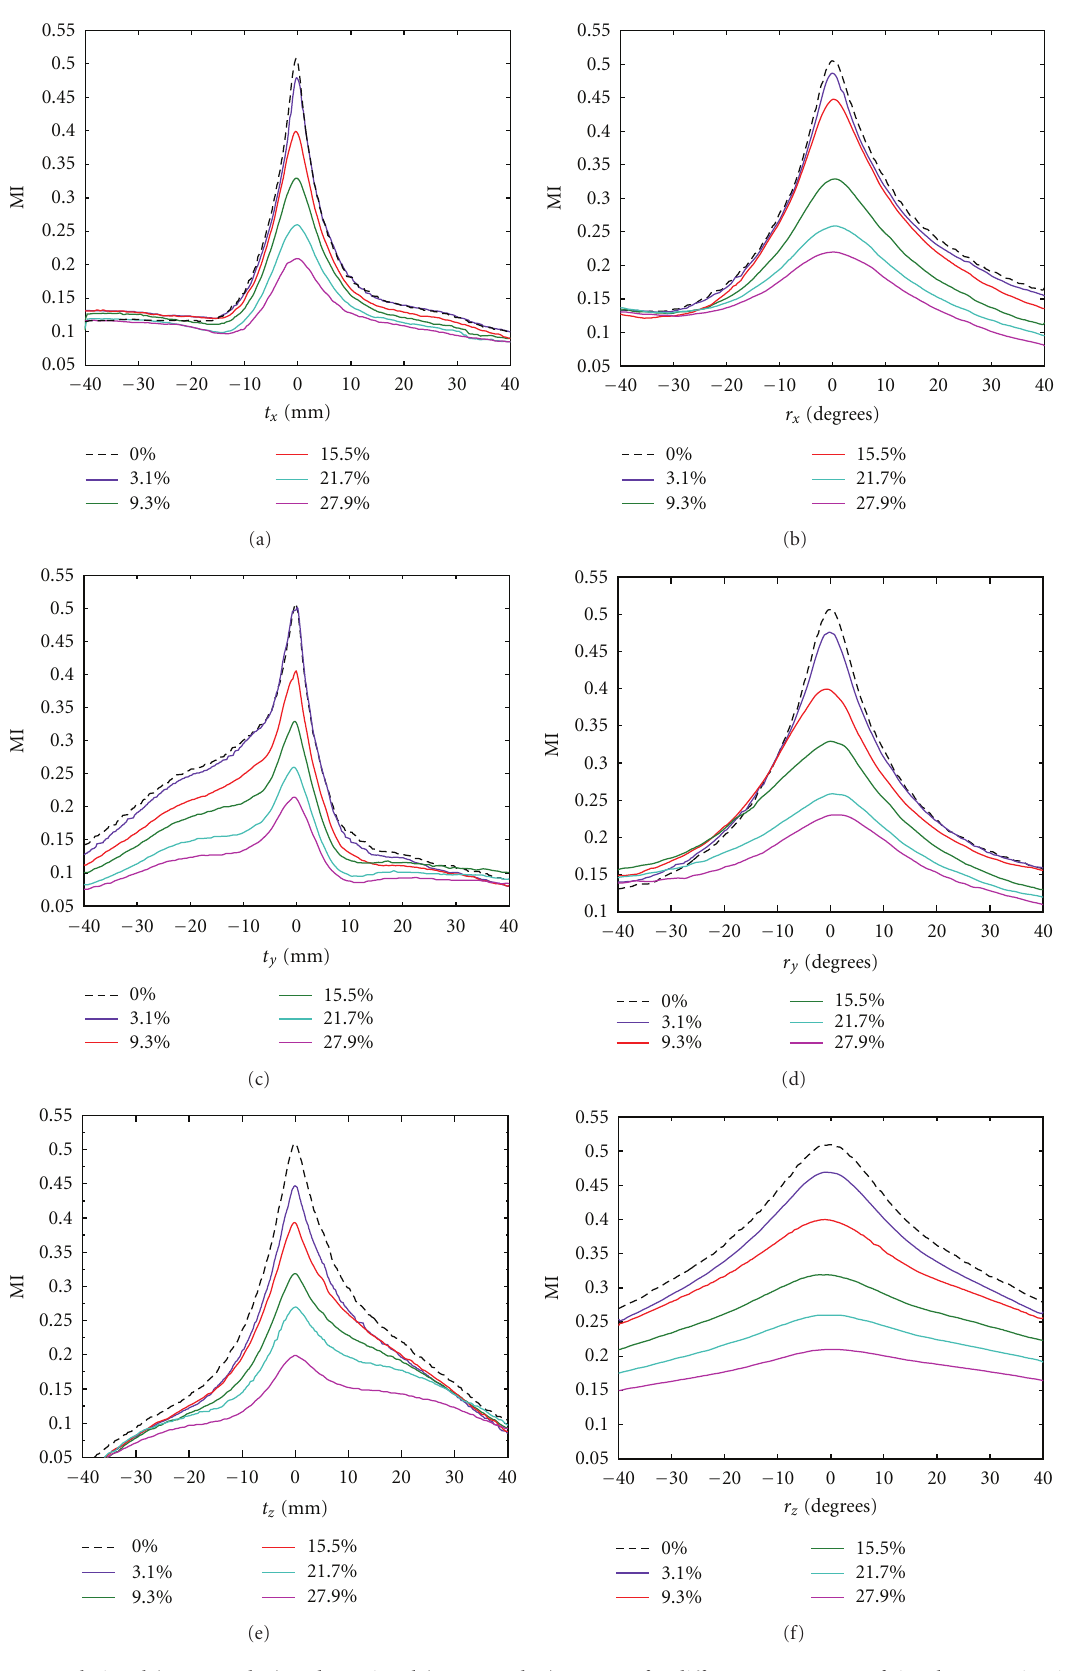
Figure 4: MI translational ( t x , t y , and t z ) and rotational ( r x , r y , and r z ) patterns for di ff erent percentages of signal attenuation in the PET